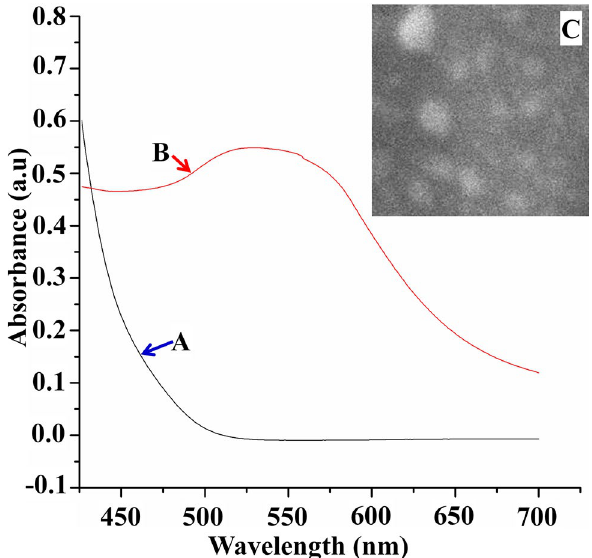
Figure 1. Gold nanoparticle synthesis. ( A ) gold chloride solution; ( B ) after the formation of AuNPs; ( C ) SEM image showing well-dispersed colloidal